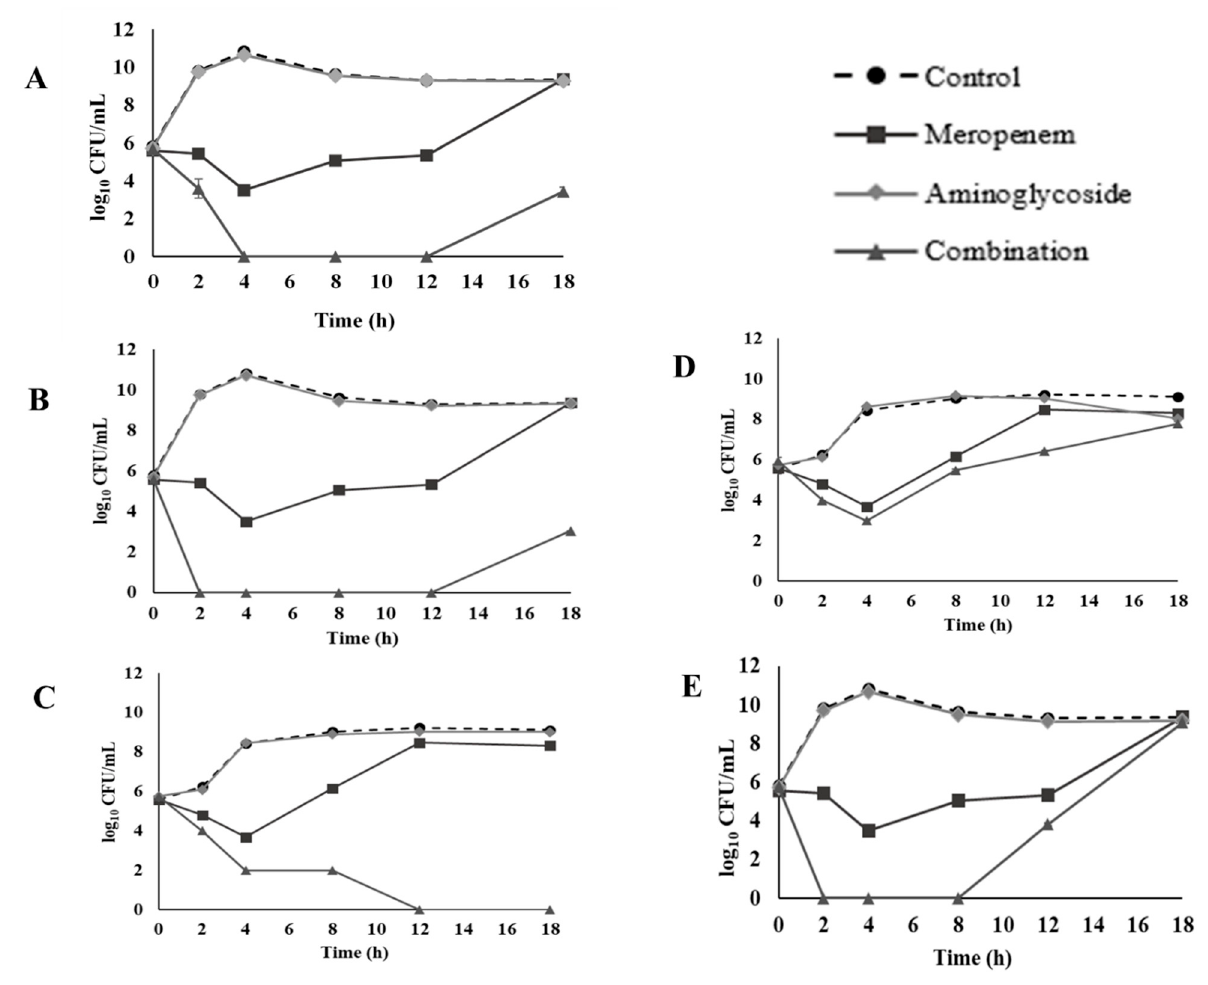
Figure 2. Time-kill curves of 1/4 MIC (32 µg/mL) meropenem and 1/4 MIC aminoglycosides combination against CREC 18: ( A ) amikacin (1 µg/mL), ( B ) gentamicin (16 µg/mL), ( C ) kanamycin (32 µg/mL), ( D ) streptomycin (64 µg/mL), and ( E ) tobramycin (8 µg/mL).